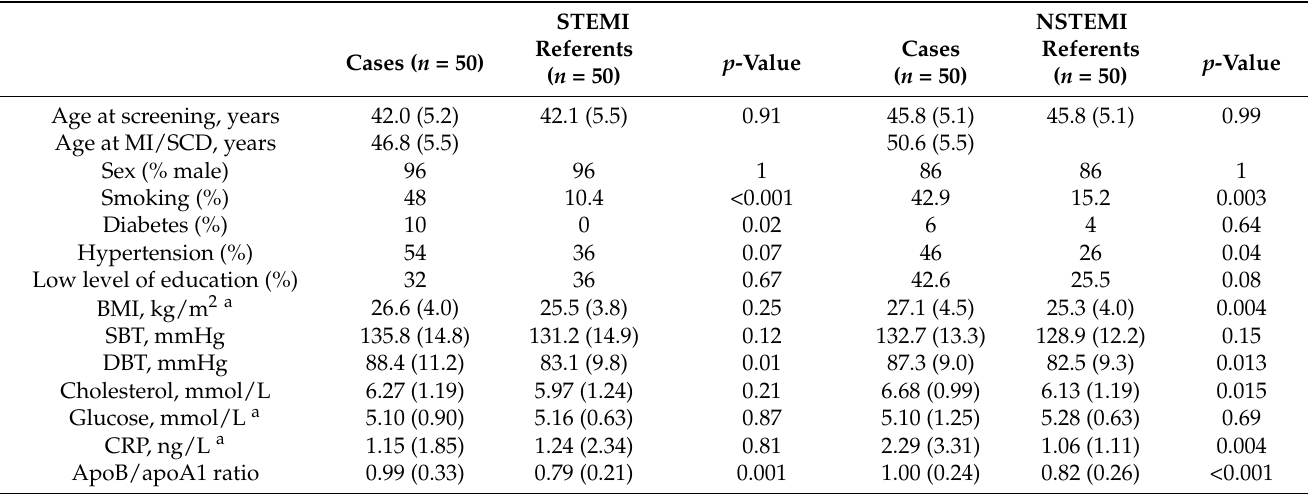
Table 1. Baseline characteristics of the cases and referents with ST-elevation myocardial infarction (STEMI) and non ST-elevation myocardial infarction (NSTEMI).